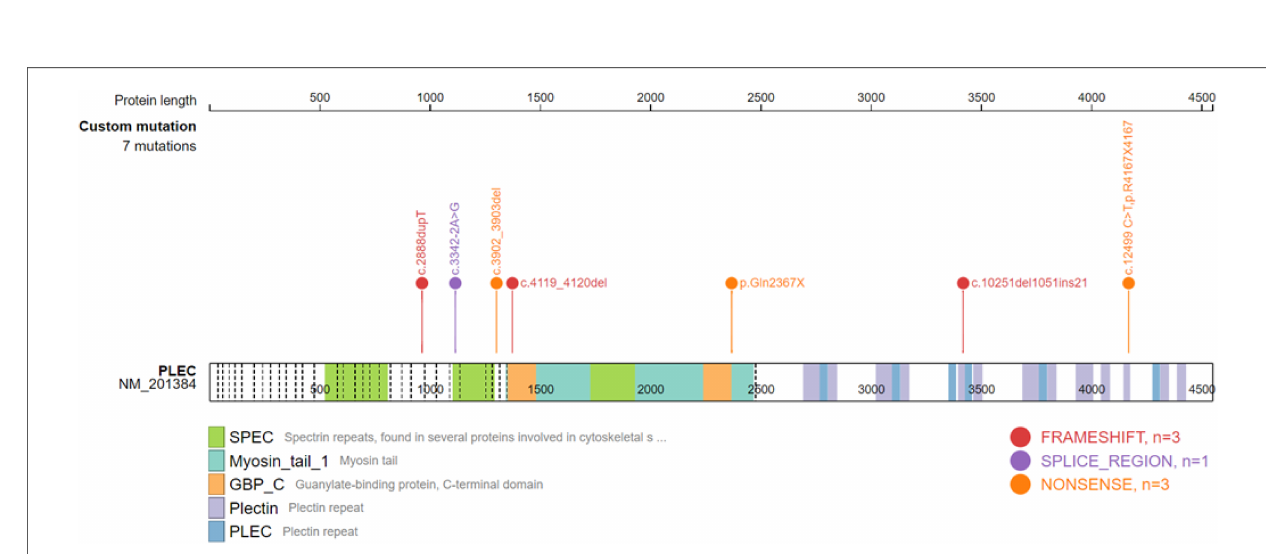
FIGURE 5 Schematic diagram of the PLEC domain and the location of the PLEC